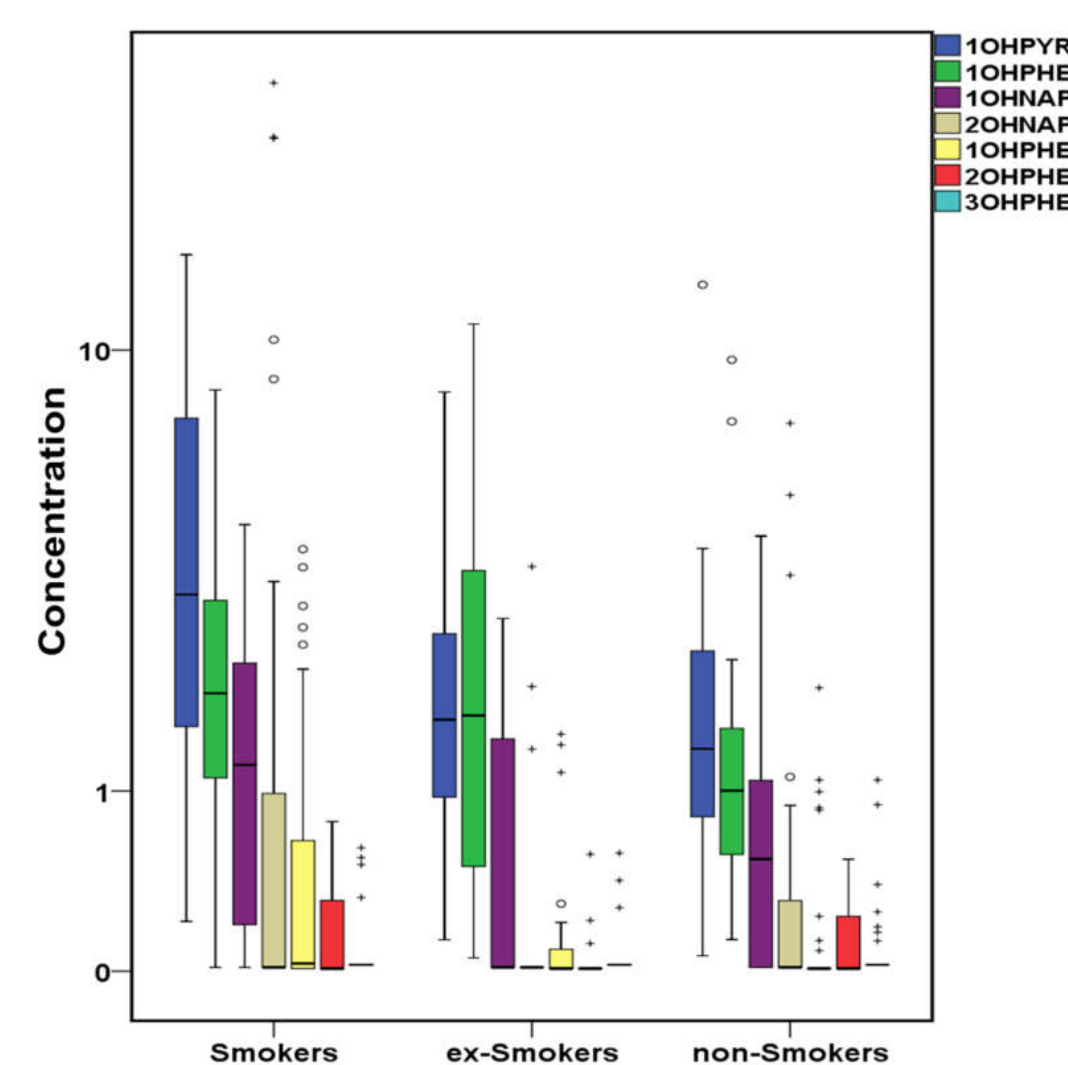
Figure 7. Variation of OHPAHs (μg L −1 ) in cases’ serum regarding the smoking habit ( + outliers, o values above 3rd quartile, and * p -value < 0.05) in logarithmic scale (1OHPYR:1-hydroxypyrene, 1OHPHE:1-hydroxyphenanthrene, 1OHNAP:1-naphthol, 2OHNAP:2-naphthol, 9OHPHE:9-hydroxyphenanthrene, 2OHPHE:2-hydroxyphenanthrene, 3OHPHE:3-hydroxyphenanthrene).